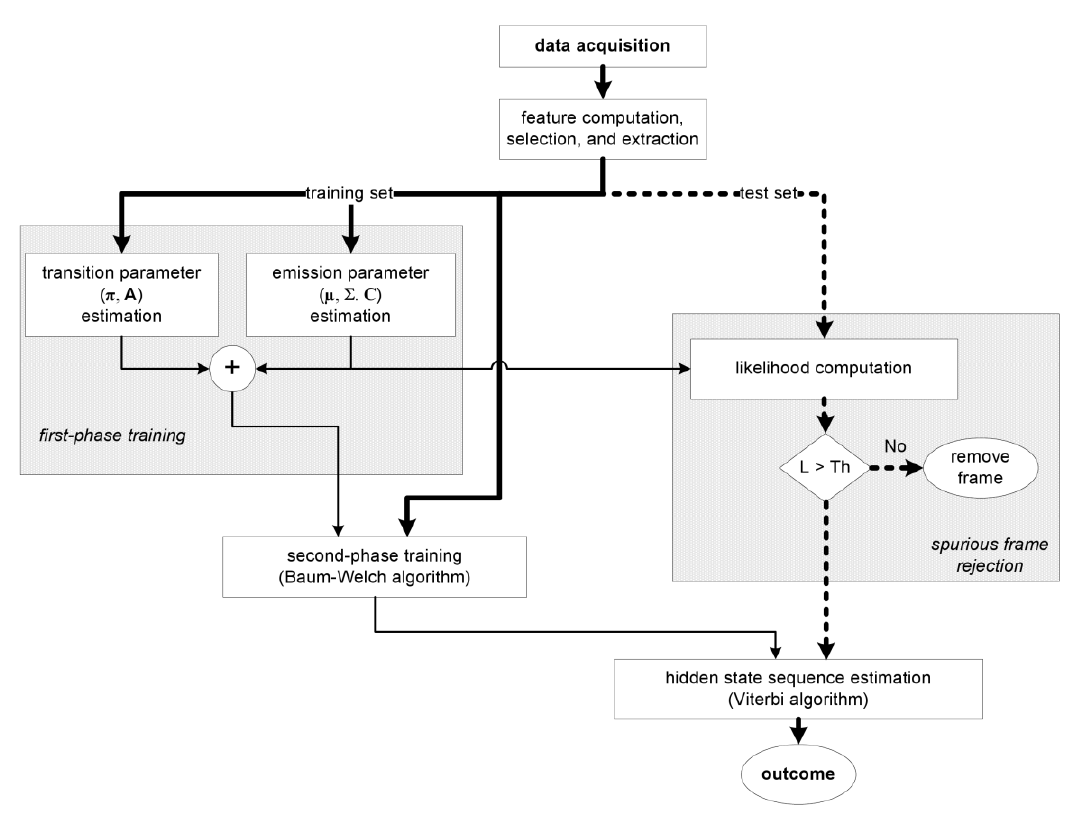
Figure 3. Block diagram of the developed cHMM-based sequential